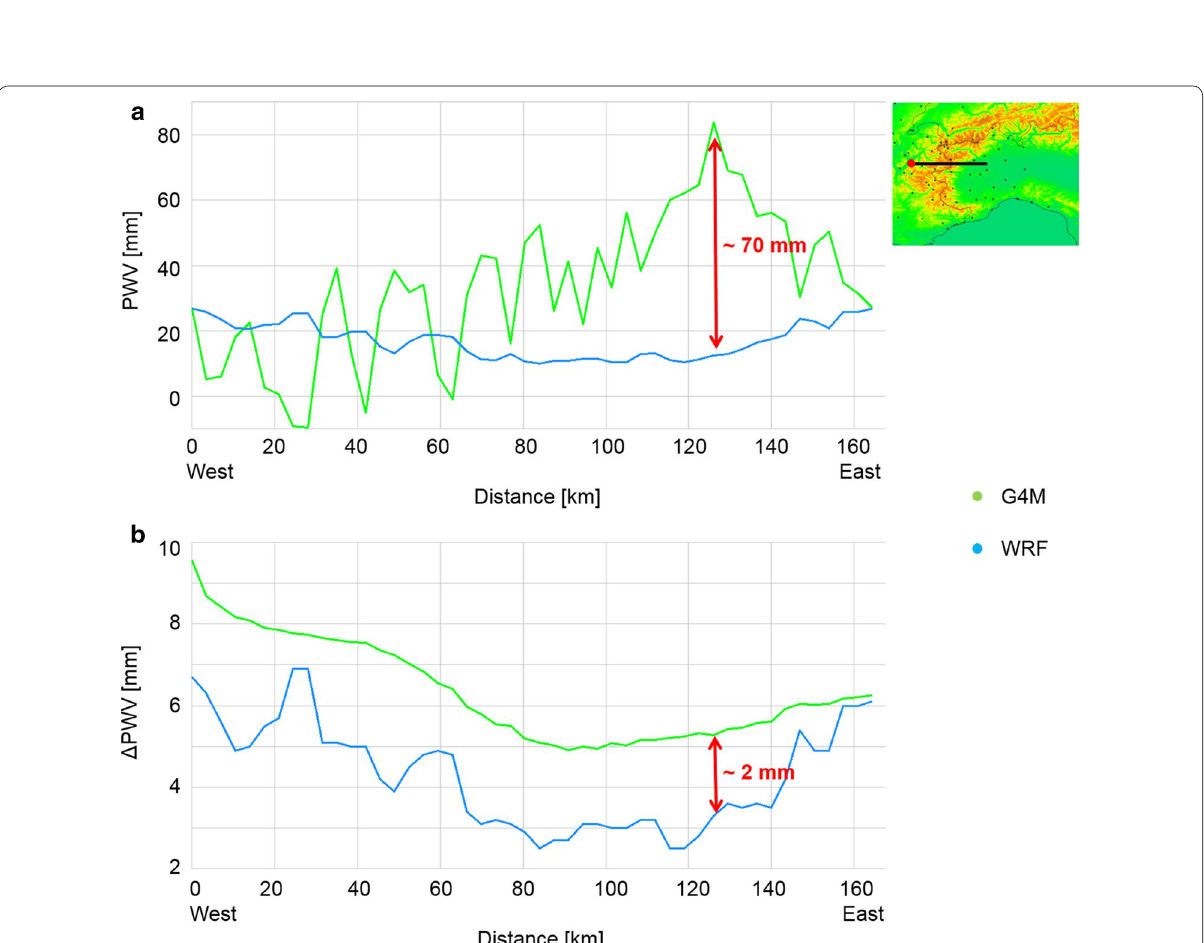
Fig. 6 PWV ( a ) and ∆PWV ( b ) values for the G4M (green) and WRF (blue). The orographic effect was successfully removed from the ∆PWV graph. The position of the section is depicted in the top right of the figure. The x -axis displays the distance in kilometers, from the start of the section (red dot) from west to east; the y -axis shows the PWV and ∆PWV